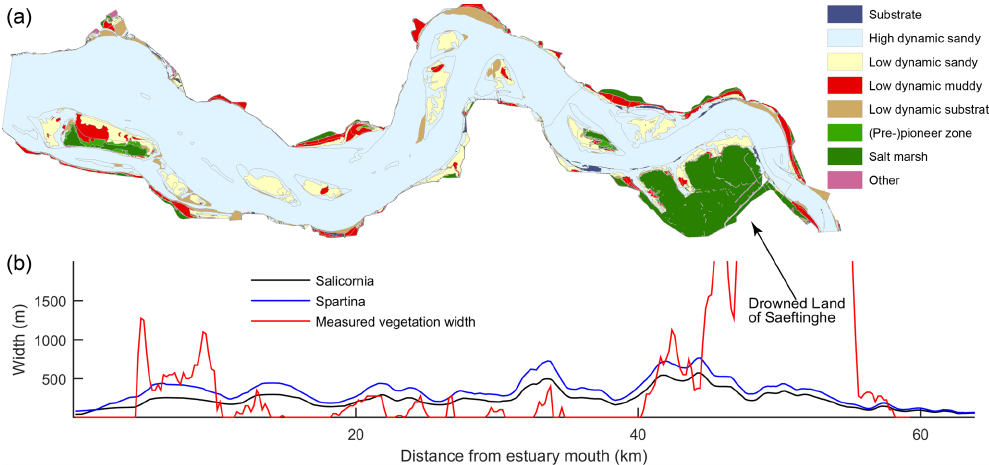
Figure 14. (a) Ecotope map of the Western Scheldt (2012) obtained from Rijkswaterstaat. (b) Prediction of the width in which Salicornia (black) and Spartina (blue) can occur when assuming that Spartina occurs between MSL and 1.5m above and Salicornia occurs between 1.0 and 2.5m, while ignoring velocity, salinity and sediment type constraints. Red line indicates measured width of vegetation based on ecotope map. The Drowned Land of Saeftinghe is excluded in the predictions because the high water line was the boundary of the analysed bathymetry, while it is included in the measured